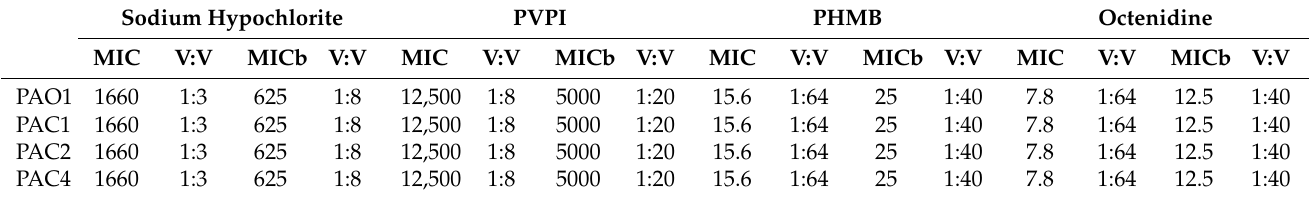
Table 1. Minimum Inhibitory Concentration (MIC) and partial biofilm Minimum Inhibitory Concen- tration (MICb) values (in 10 − 3 g · L − 1 ) and dilution ratios (in V:V) determined for the reference strain PAO1 and three clinical P. aeruginosa strains (PAC1, PAC2 and PAC4) against four antiseptic solutions. Sodium Hypochlorite PVPI